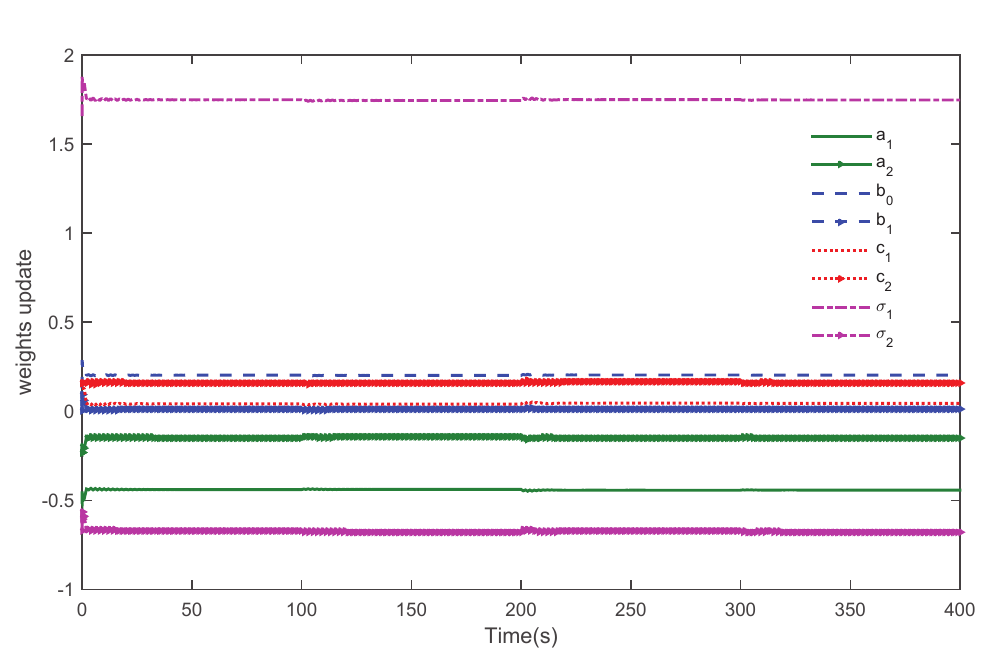
Figure 10. The curves of the Wiener-type neural network weight